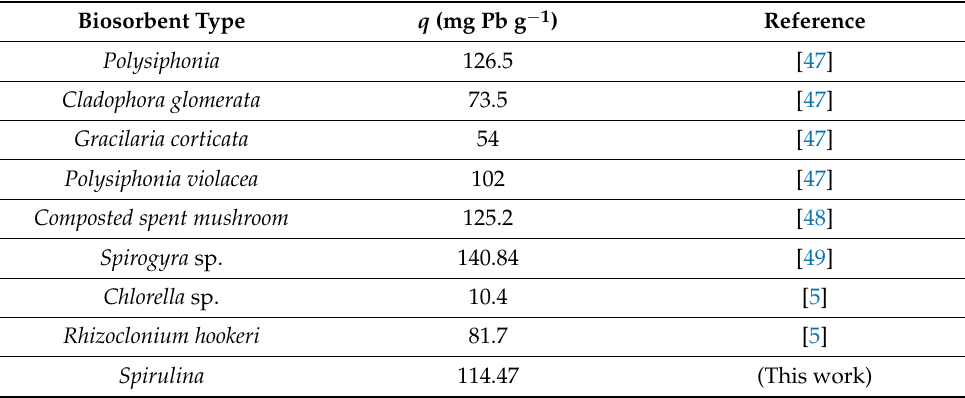
Table 2. Adsorption capacity of Pb (II) by different biosorbents.